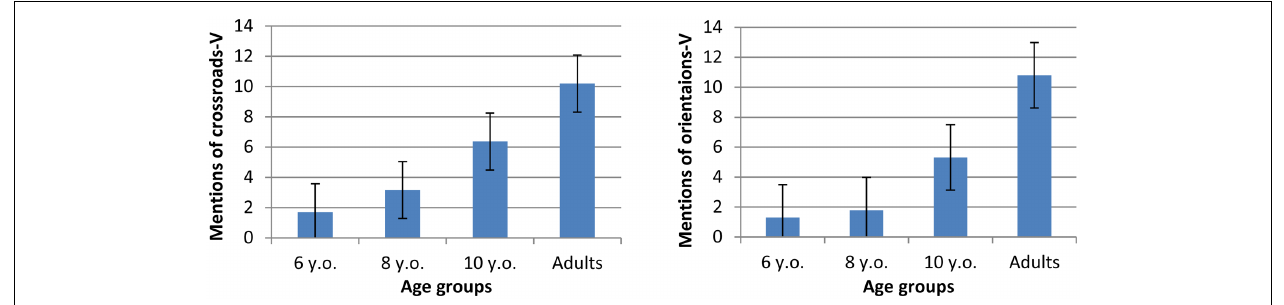
FIGURE 8 | Mean number of mentions of crossroads and orientations in verbal